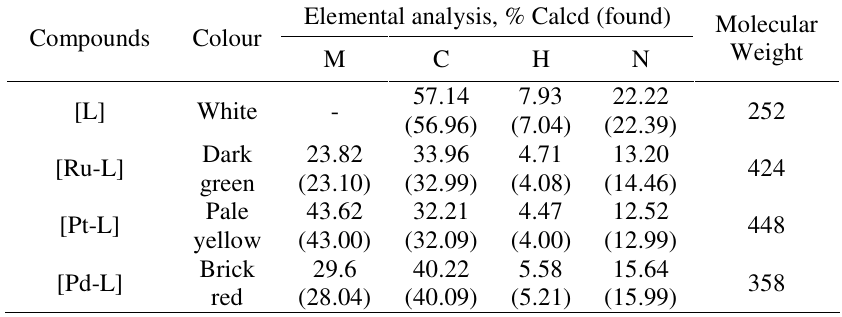
Table 1. Analytical data of tetra-aza macrocyclic ligand (L) and its complexes. Elemental analysis, % Calcd (found) Compounds